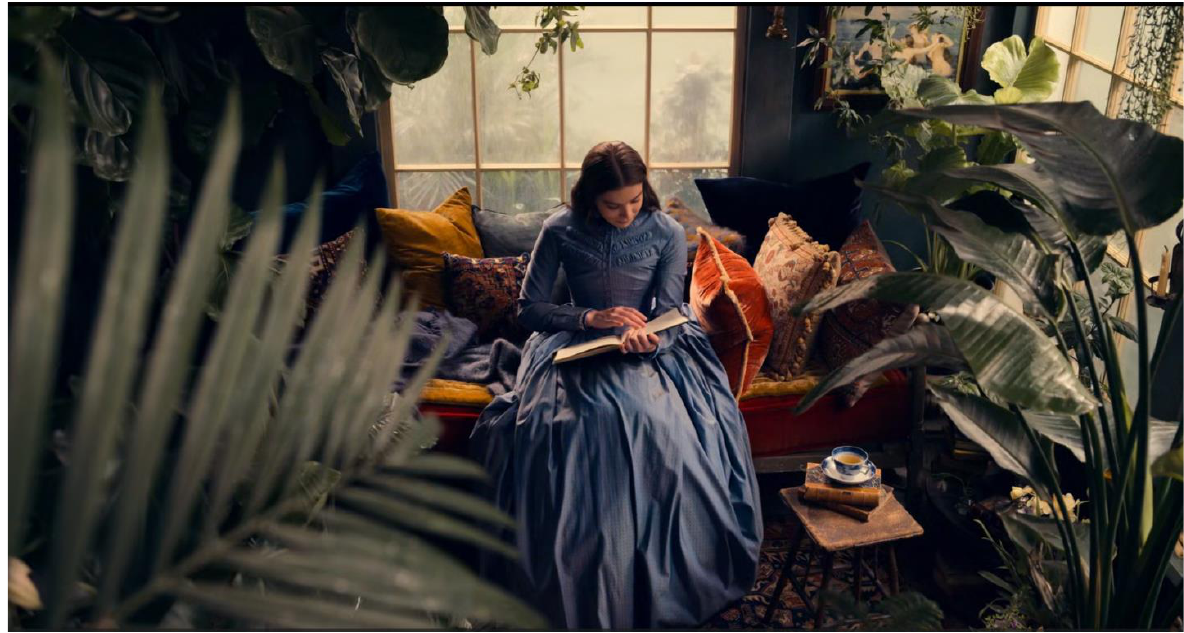
Figure 3. Emily immerses herself in her newly arrived copy of Leaves of Grass , ensconced with her blue and white teacup and saucer in the conservatory surrounded by plants, including a 2020 pandemic favorite, the fiddle-leaf fig.